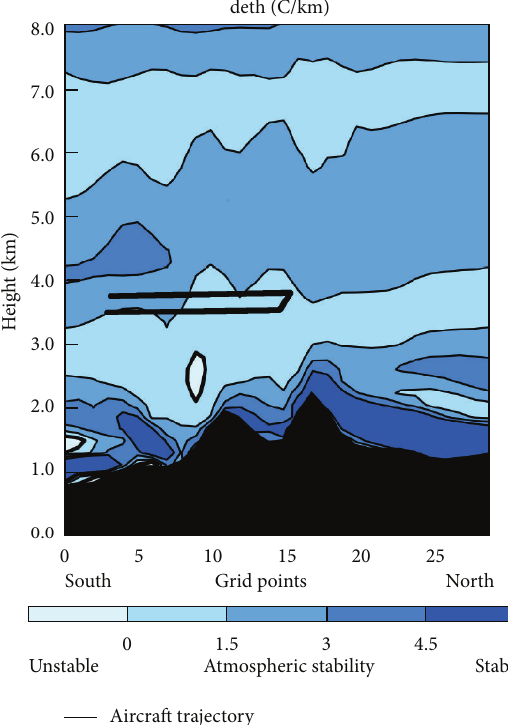
Figure 13: Cross section of deth in